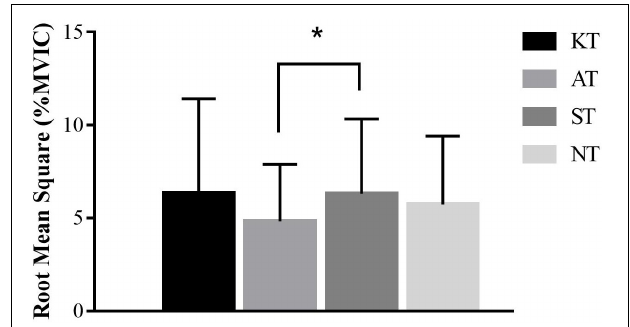
FIGURE 4 | Comparison of root mean square values (%MVIC) in toes-down rotation during adaption test for peroneal longus. *means significant difference during different taping